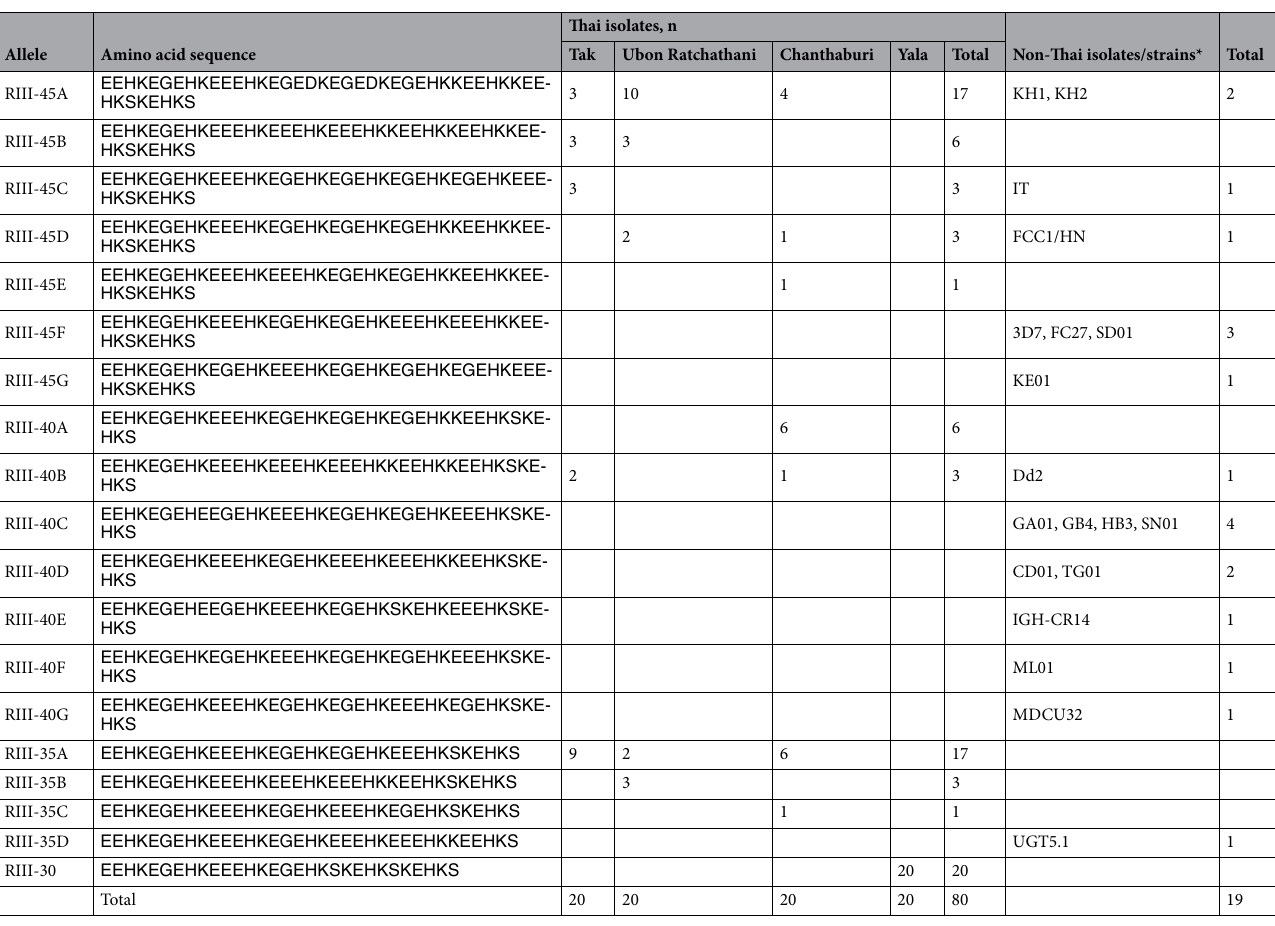
Table 3. Diversity and distribution of repeat alleles in block 6 (repeat domain III) of PfGARP. MDCU32 is from a Guinean patient. *GenBank accession numbers are listed in “Materials and methods”.